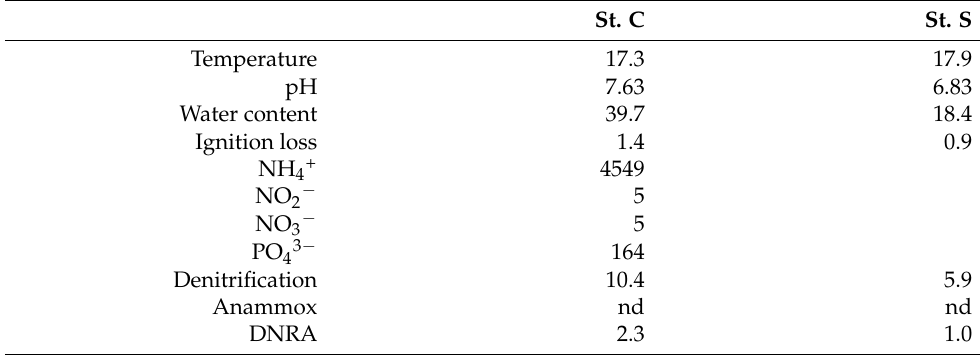
Table 1. Temperature ( ◦ C); pH; water content (%); ignition loss (%); NH 4+ , NO 2 − , NO 3 − , and PO 43 − concentrations ( µ g-N or -P L − 1 ); and denitrification, anammox, and DNRA rates ( µ g-N g-dry − 1 day − 1 ) in the surface sediments at the Yatsu tidal flat in November